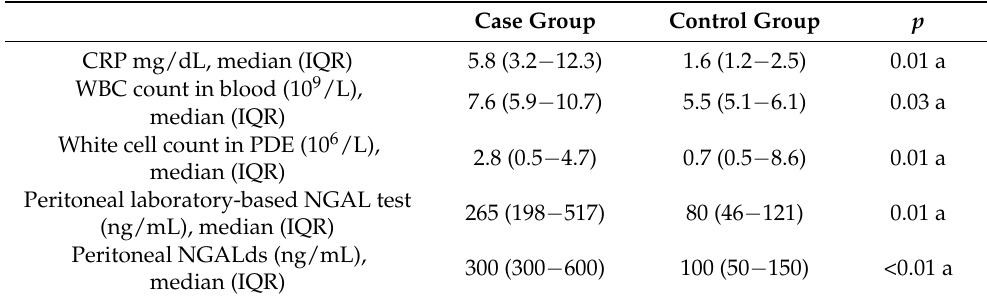
Table 3. Inflammatory biomarkers in PD patients with (case group) and without (control group)